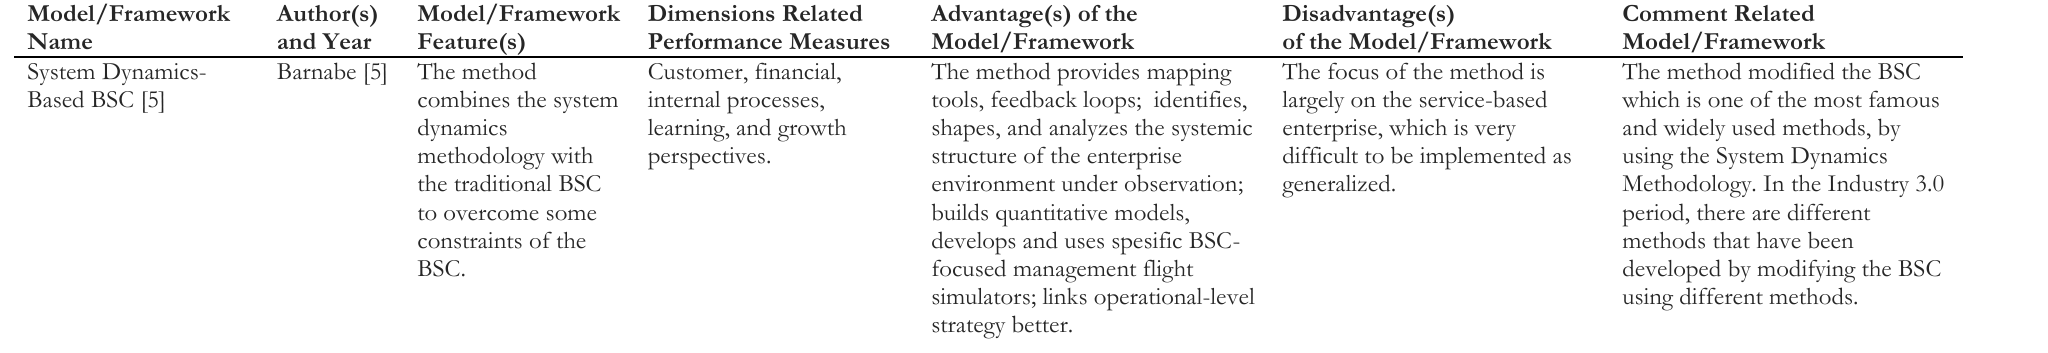
Table 12. Organizational performance measurement models developed in Industry